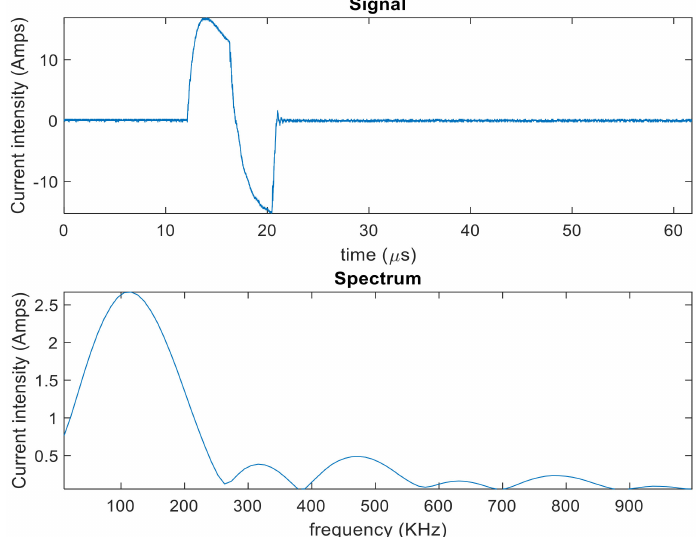
Figure 3. The current waveform from the high-power pulsing unit that was injected into the excitation coil above the removable MPT, showing both the current waveform ( top ) and the corresponding frequency spectrum ( bottom